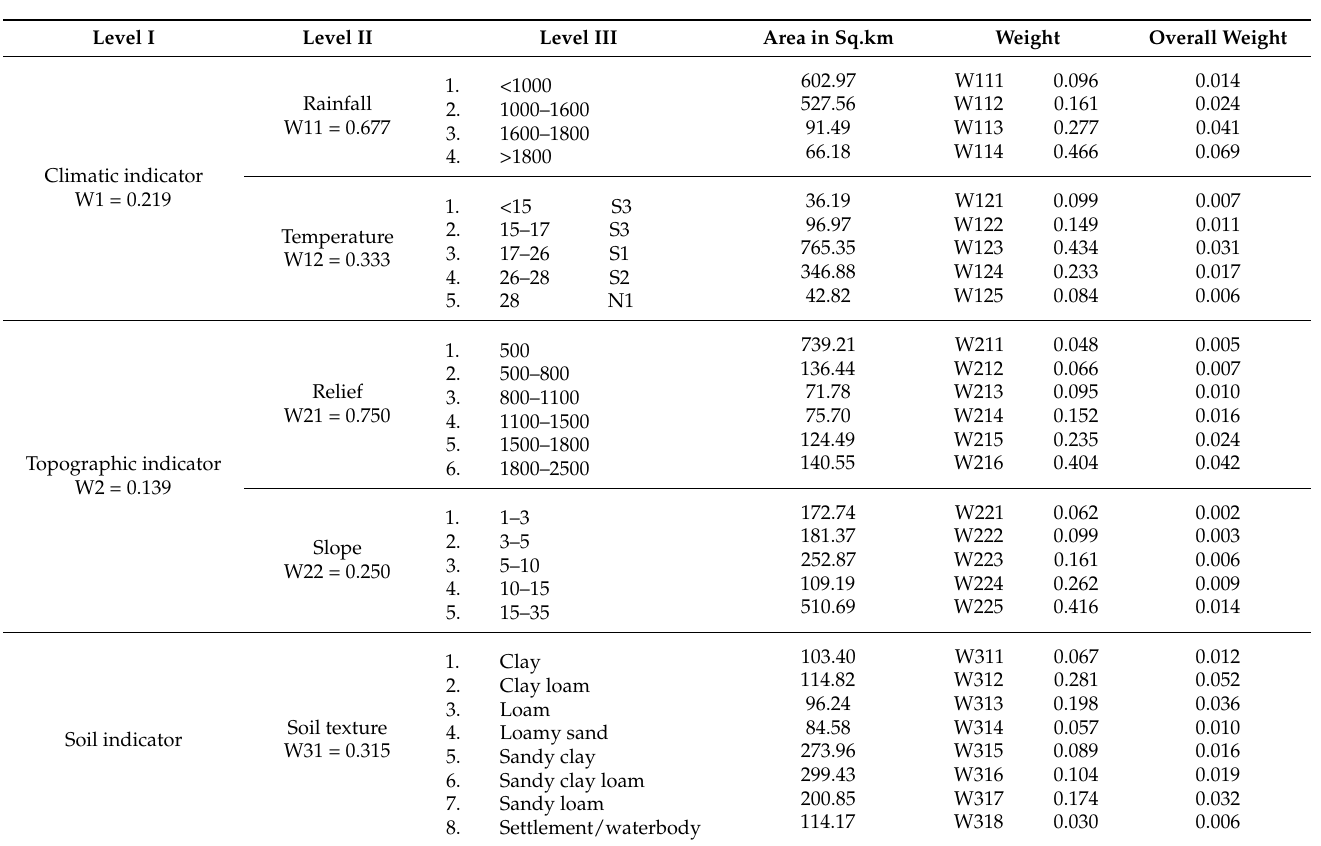
Table 8. Criteria and sub-criteria